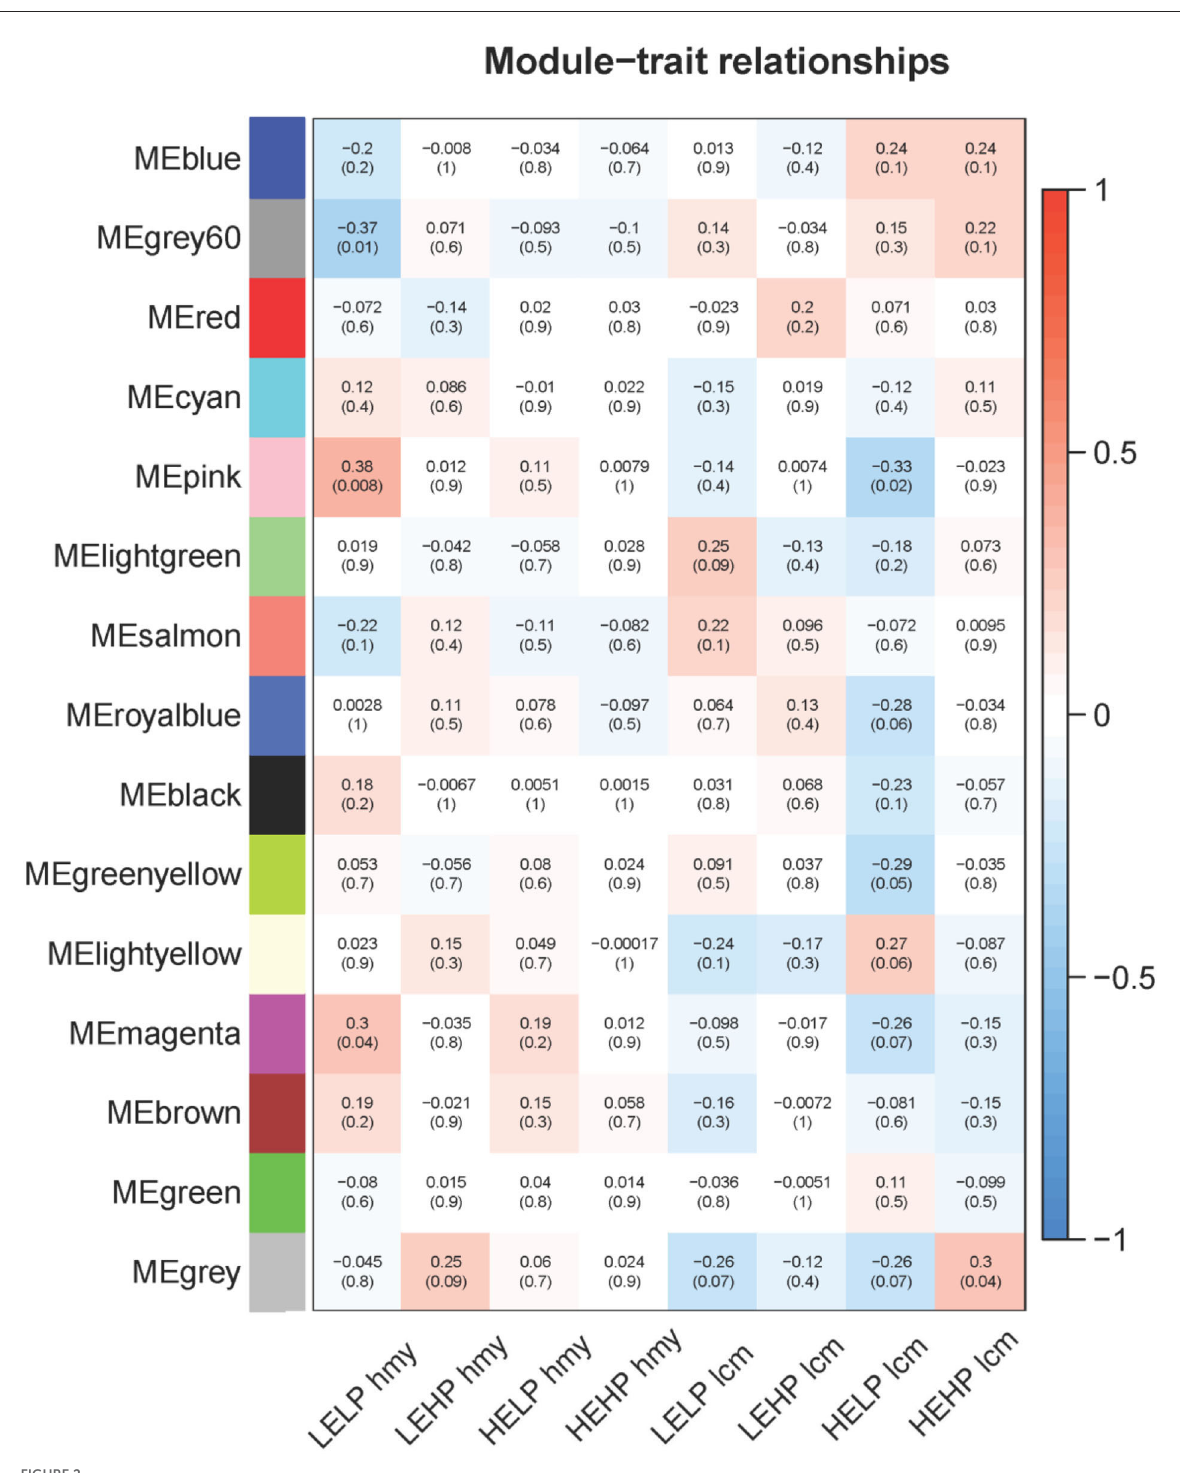
FIGURE2 Relationship between modules and different feeding methods. The numbers on the top of the block represent the correlation and the p -value on the bottom. The horizontal axis represents the different feeding methods, and the vertical axis represents the eigenvector of each module. Red means positive correlation, and blue means negative